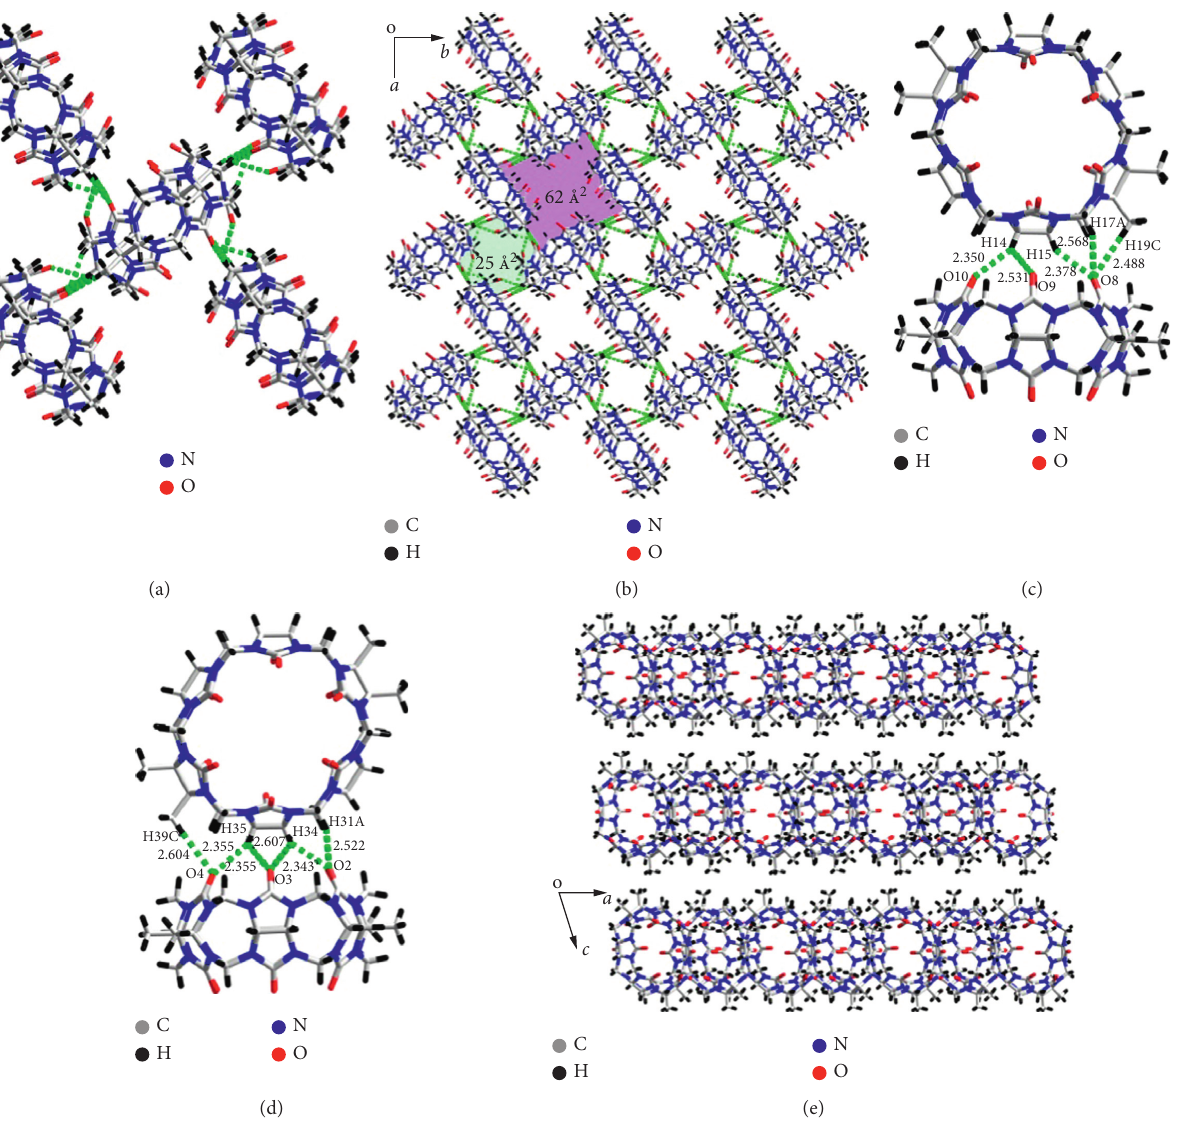
Figure 2: Crystal structure of (a) supramolecular interactions between the central TMeQ[6] molecule and four neighbouring TMeQ[6] molecules in A ; (b) a TMeQ[6]-based 2D supramolecular assembly; (c, d) detailed interactions between neighbouring TMeQ[6] molecules and crystals; (e) stacking structure from ac plane in compound A